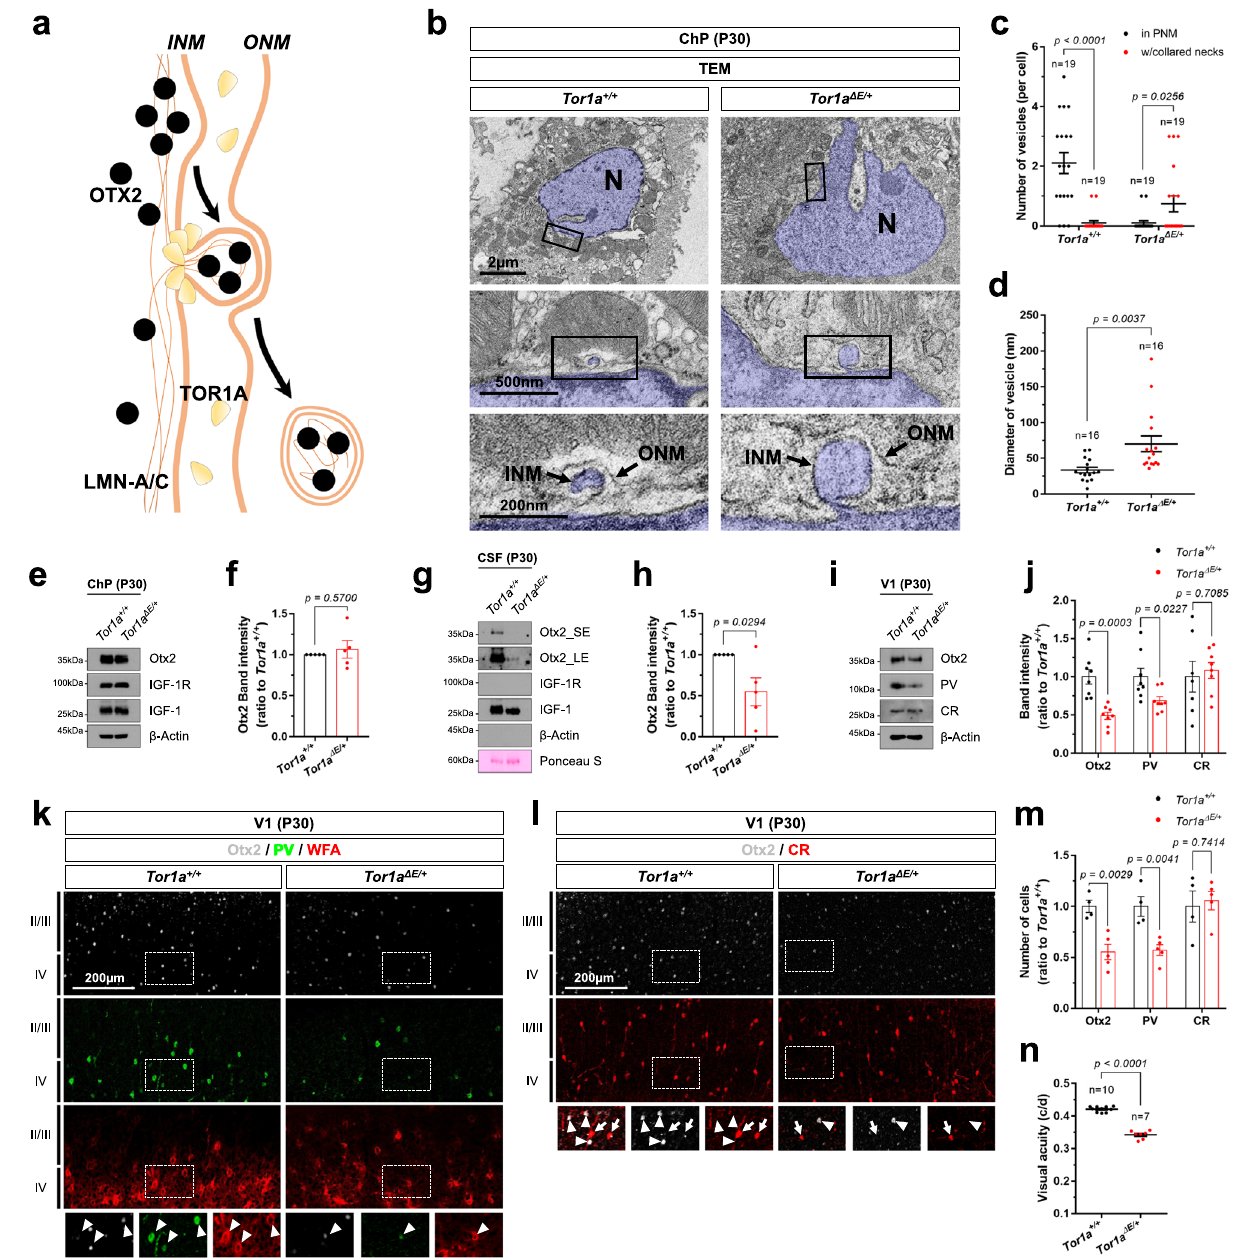
Fig. 5 | Otx2 secretion is suppressed in Tor1a Δ E/+ mice. a The diagram shows the TOR1A-mediated nuclear egress of OTX2, which forms double nuclear membrane vesicles containing LMN-A/C. b Sections (70nm) of ChP from P30 Tor1a +/+ and Tor1a Δ E/+ littermate mouse brains were counterstained for electron microscopic observation of intracellularstructures. Boxed areasin the topand middle rows are magni fi ed in the middle and bottom rows, respectively. Nuclei (N) of the cells are pseudo-colored in blue. c A dot in the graphs represents the number of vesicles in the perinuclear membrane space (PNM) and vesicles with collared necks in a cell. d A dot in the graphs represents the average diameters of vesicles in a cell. The numbers of cells analyzed are shown in the graphs. Long sidebars indicate mean values and error bars denote SEM obtained from 8 different samples (4 indepen- dent litters). The ChP ( e ), CSF ( g ), and V1 area of cerebral cortex ( i ) were isolated from P30 Tor1a +/+ and Tor1a Δ E/+ mice ( n =4, each), and the levels of Otx2 in those samples were examined by WB. Relative amounts of proteins loaded in each lane were examined by comparing band intensities of ß-Actin ( e , i ) and 60kDa